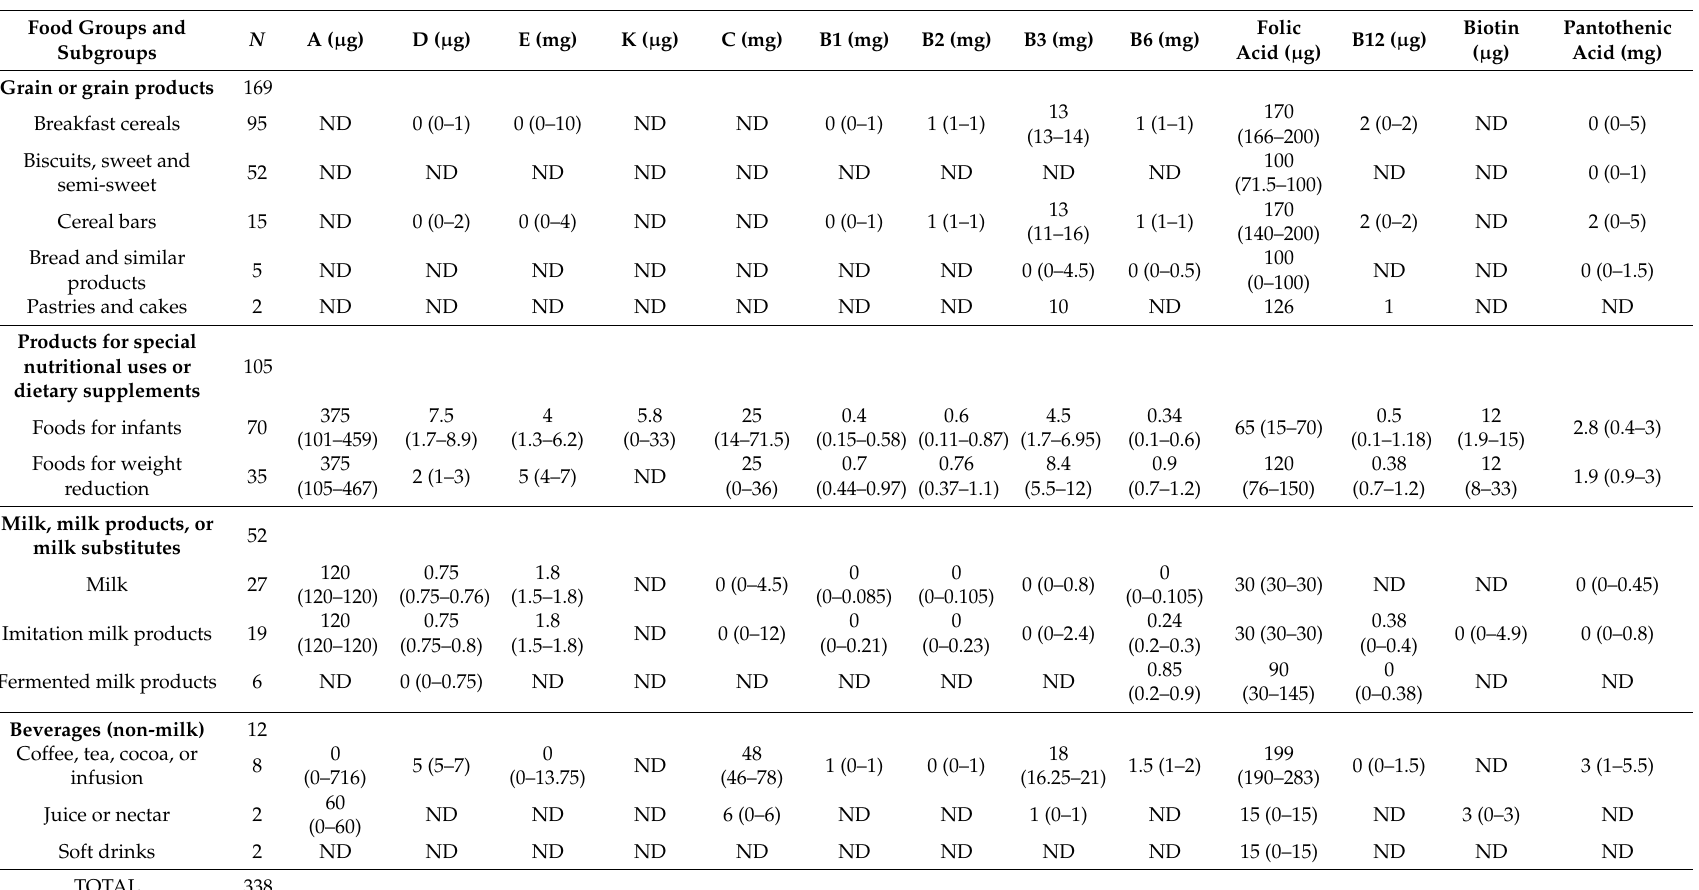
Table 2. Vitamin content distribution in folic acid-fortified food products from the Spanish